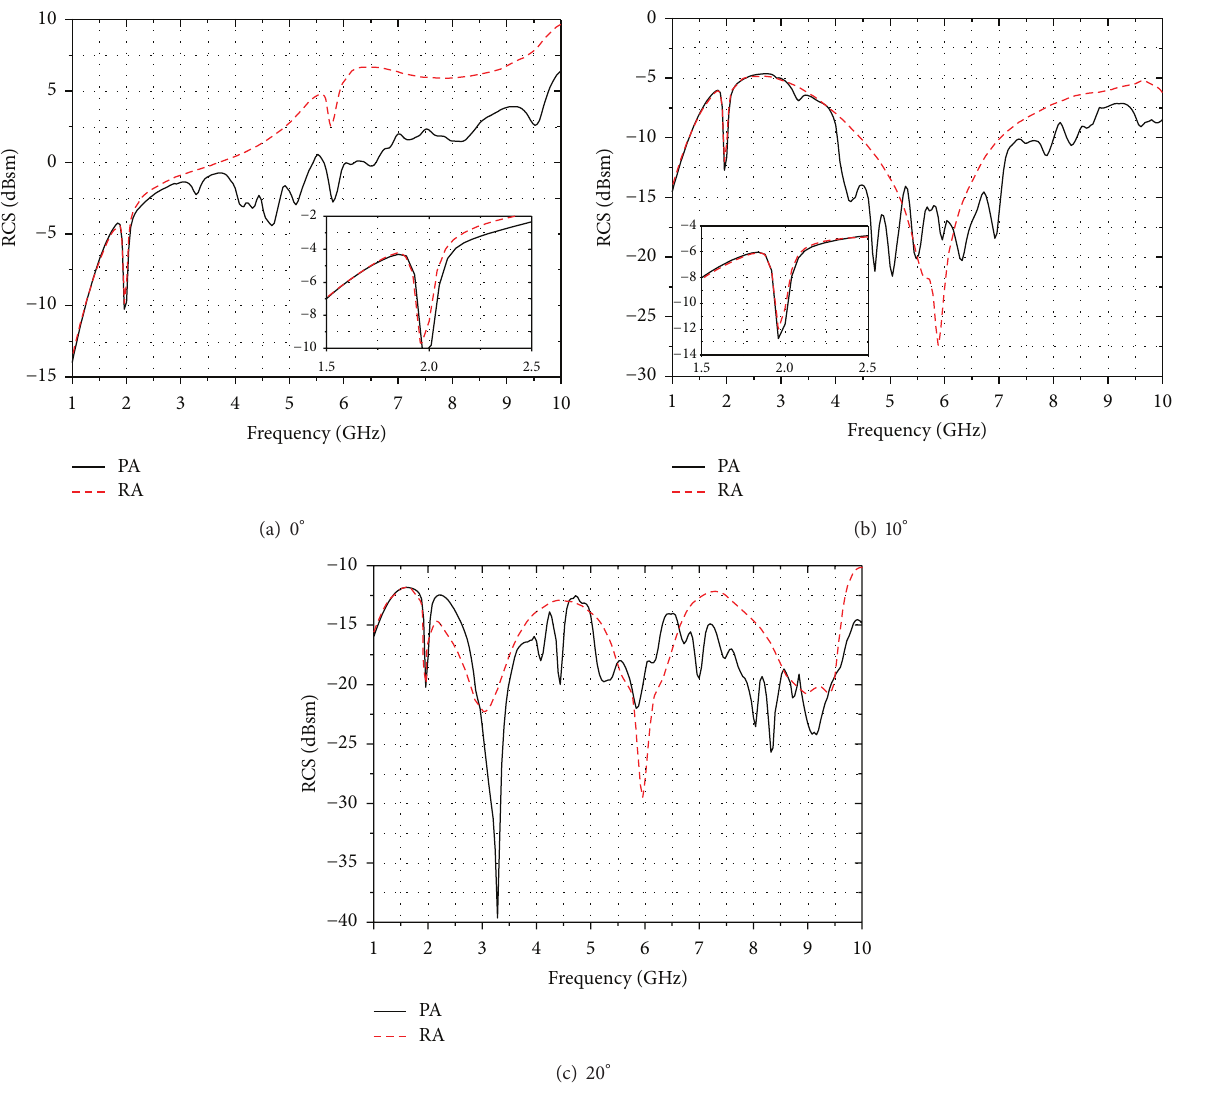
Figure 12: Bistatic RCS with incident